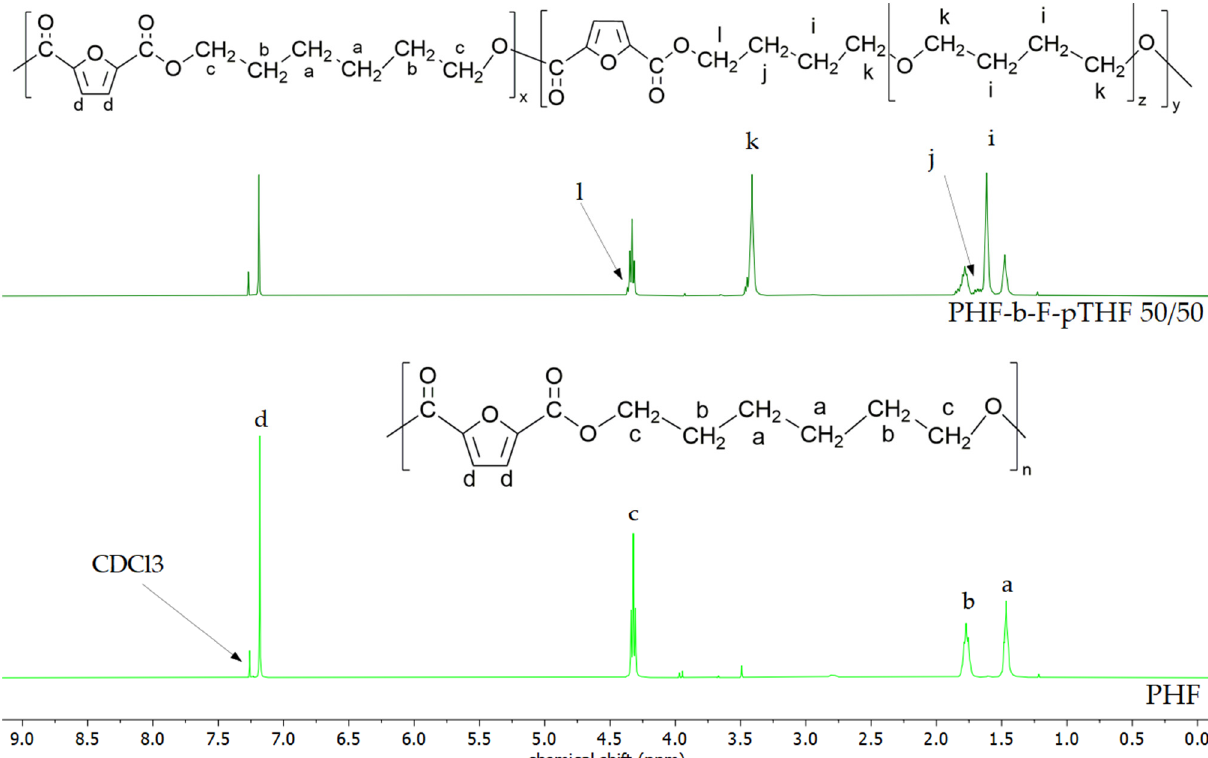
Figure 2. Structure of polyesters and their NMR spectra.